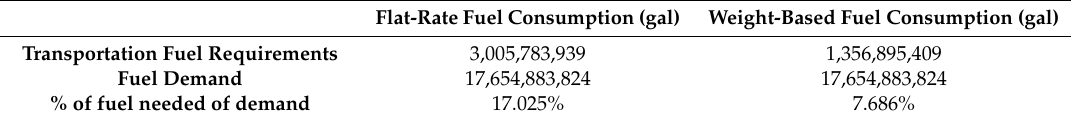
Figure 15. Supply chain optimization for the case of United States. These results indicate that 65% of the marginal farmland of the State of Mississippi is needed to supply the U.S. demand for biodiesel in the states in which the demand locations are located. Table 11. Fuel consumption and demand for the U.S. case. Table 11. Fuel consumption and demand for the U.S. case.